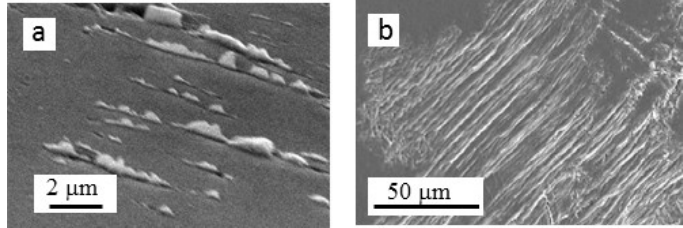
Figure 3: SEM micrographs of damaged traces in the post-fatigued specimens: (a) SBs at  a = 240 MPa ( N f =1.95×10 5 ); (b) slip band like traces at  a = 90 MPa ( N f =1.33×10 7 ) .